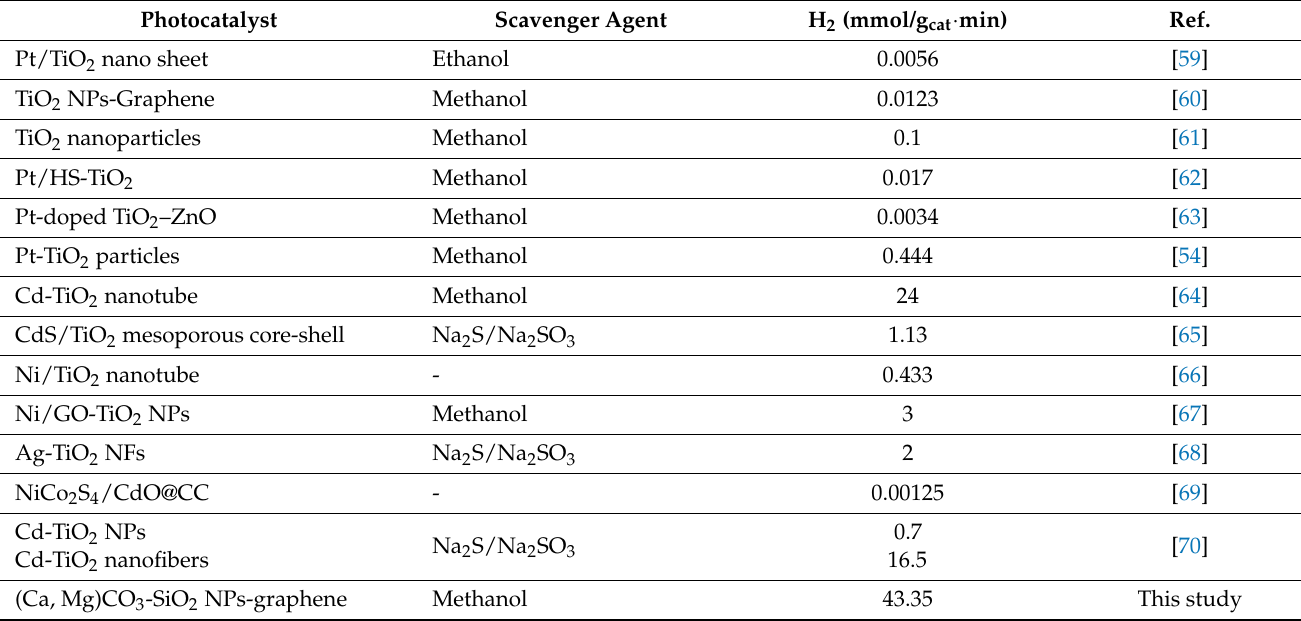
Table 2. Hydrogen evolution rate for reported